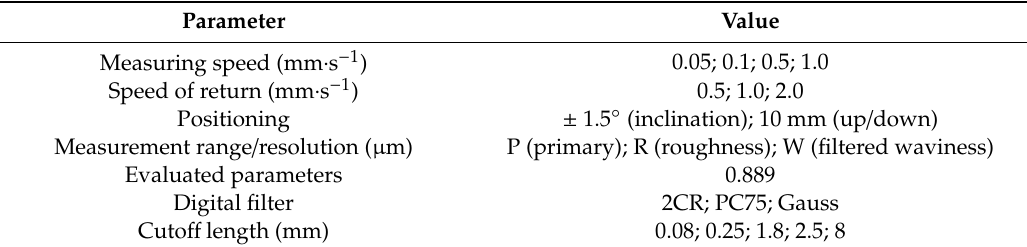
Table 4. Technical parameters of the Mitutoyo SJ400 roughness tester.